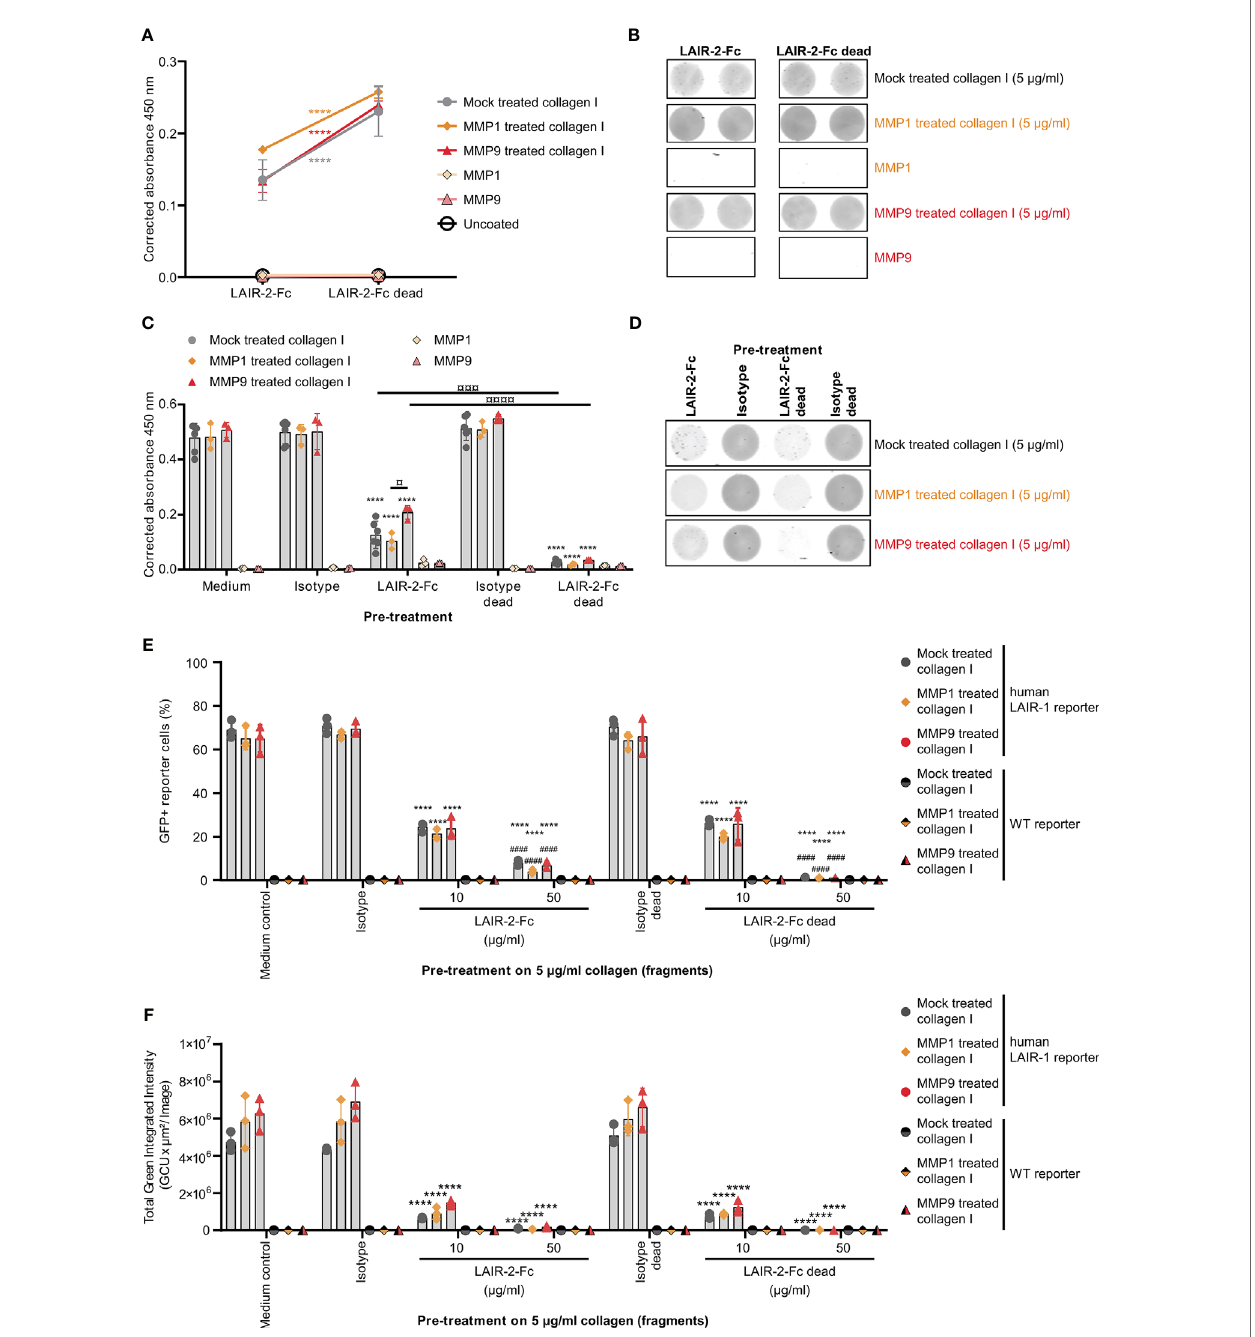
FIGURE 5 | LAIR-2 fusion proteins block LAIR-1 activation by collagen I fragments. (A) LAIR-2-Fc and LAIR-2-Fc dead binding to 5 m g/ml coated mock treated, MMP1 treated and MMP9 treated collagen I by ELISA based immune binding assay (n = 3 with technical duplicates). Symbols represent the mean and whiskers indicate the standard deviation. (B) LAIR-2-Fc and LAIR-2-Fc dead binding by fl uorescence based immune binding assay (representative of n = 3). (C) LAIR-1-Fc ELISA based immune binding assay after pre-treatment with LAIR-2-Fc and LAIR-2-Fc dead of 5 m g/ml mock treated, MMP1 treated and MMP9 treated collagen I (n = 3 with technical duplicates). (D) LAIR-1-Fc fl uorescence based immune binding assay after pre-treatment with LAIR-2-Fc and LAIR-2-Fc dead (representative of n = 3). (E) Flow cytometry analysis of GFP+ reporter cells, representing LAIR-1 activation, after pre-treatment with LAIR-2 fusion proteins (n = 3 with technical duplicates). (F) Quanti fi cation of the total green integrated intensity in the images from the live-cell IncuCyte imaging at 24 hours upon stimulation with pre-treated 5 m g/ml coated, differently treated collagen I (n = 3 with technical duplicates). In (C, E, F) * indicates statistically signi fi cant differences compared to the respective isotype control (isotype for LAIR-2-Fc and isotype dead for LAIR-2-Fc dead). # indicates statistically signi fi cant differences compared to the respective 10 m g/ml pre- treatment. In all panels, signi fi cance is tested using a two-way ANOVA with Tukey ’ s multiple comparison